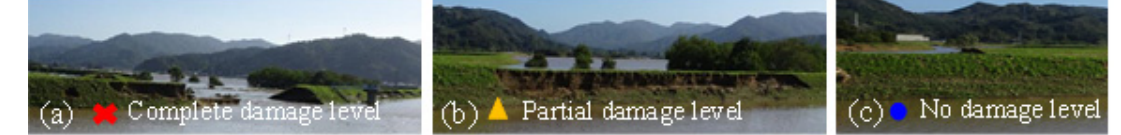
Figure 13. Classification of levee damage level ( a ) Complete damage level, ( b ) Partial damage level, ( c ) No damage level.